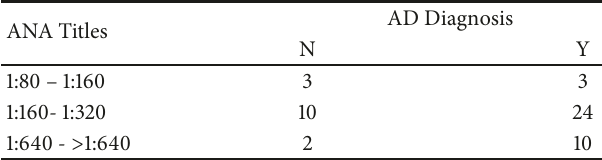
Table 1: Titers of ANA tests and clinical diagnosis of autoimmune diseases in anti-ENA-positive patients.